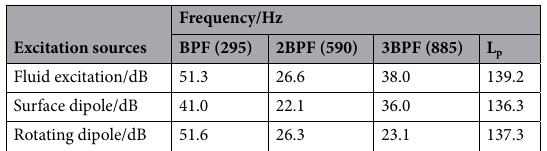
Table 4. Sound pressure levels for outfield noise at characteristic